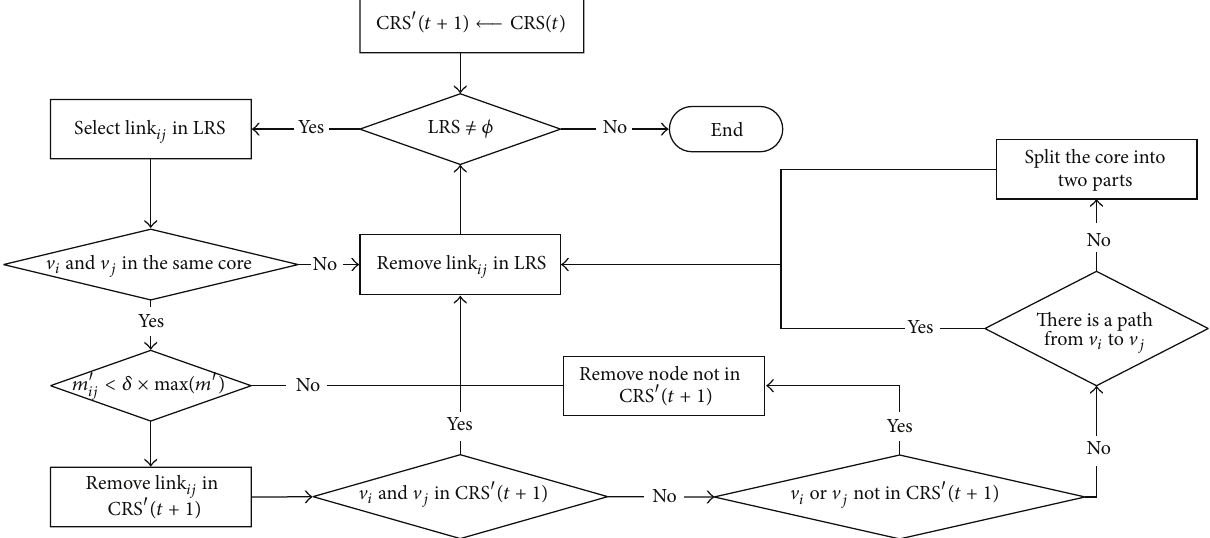
Select link ij in LRS